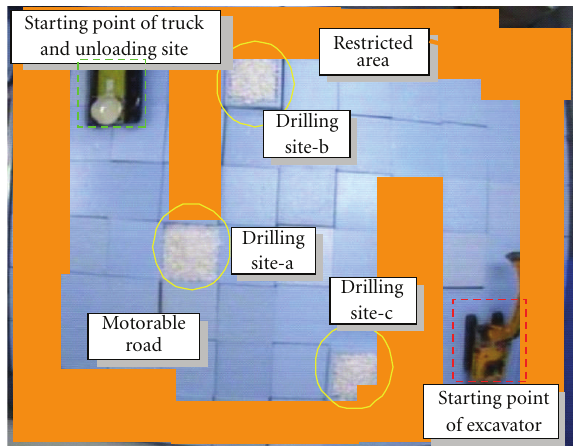
Figure 6: Overview of the work